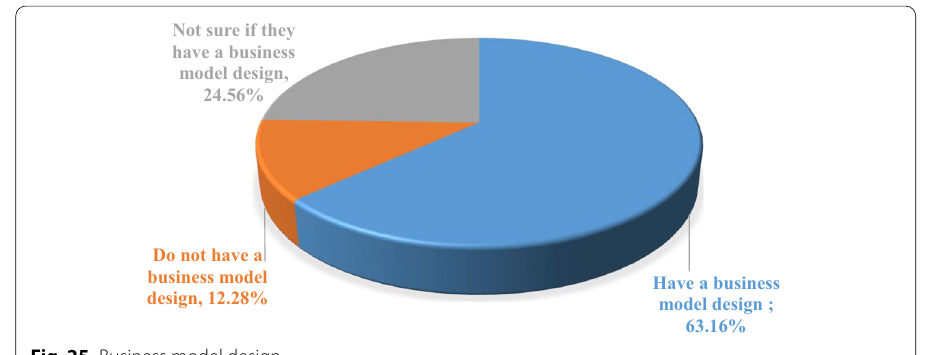
Fig. 25 Business model design